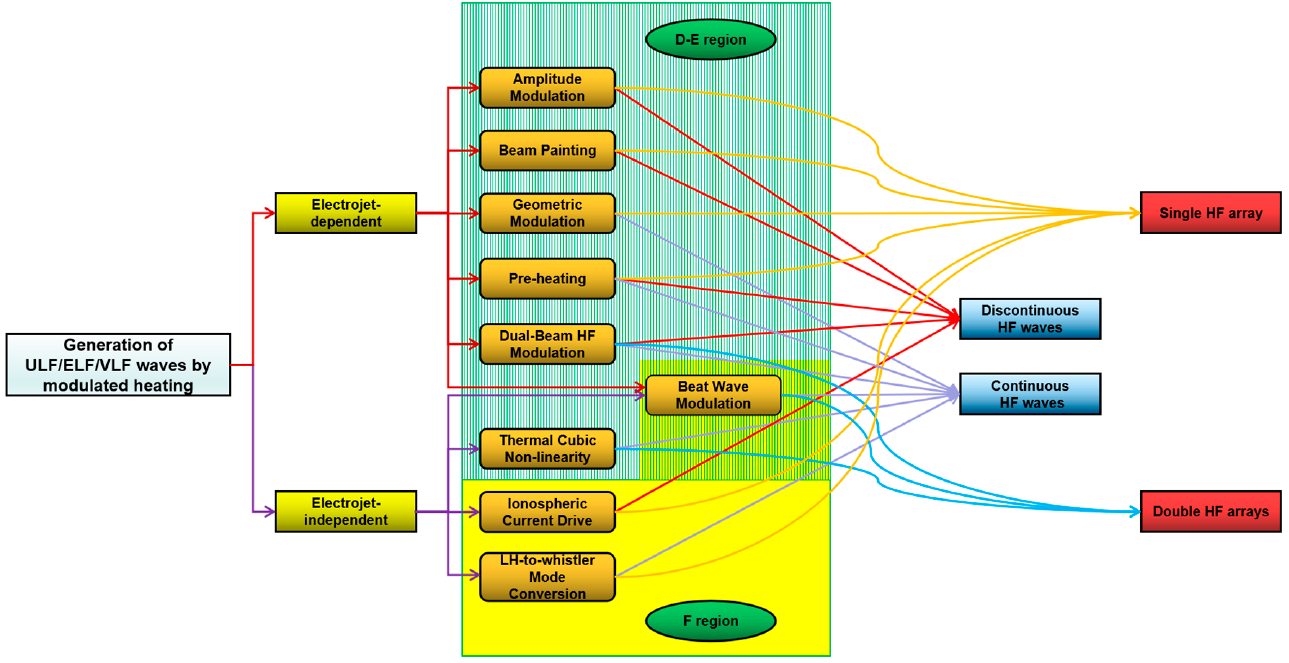
Figure 8. Classification of different modulation methods based on different characteristics (the dependence of the electrojet, the location of the source region, continuous or discontinuous waves, and the number of HF arrays).